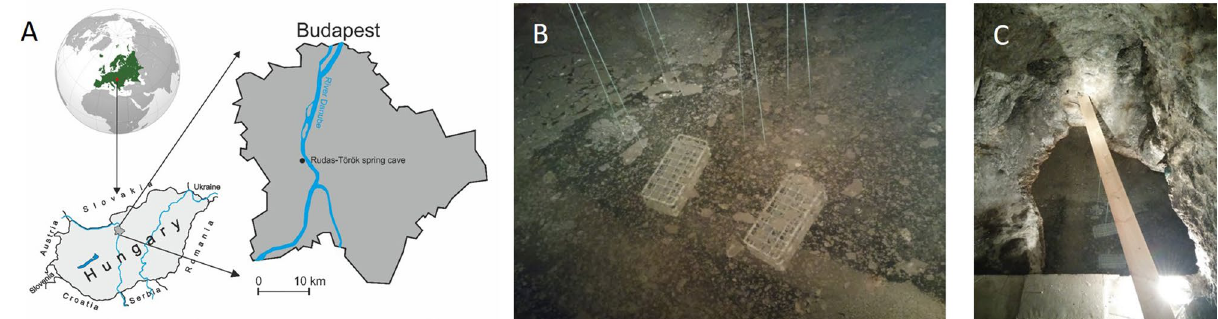
Figure 1. Geographic location of the sampling site ( A ). The arrangement of the in situ experimental model system in the RT spring cave ( B , C